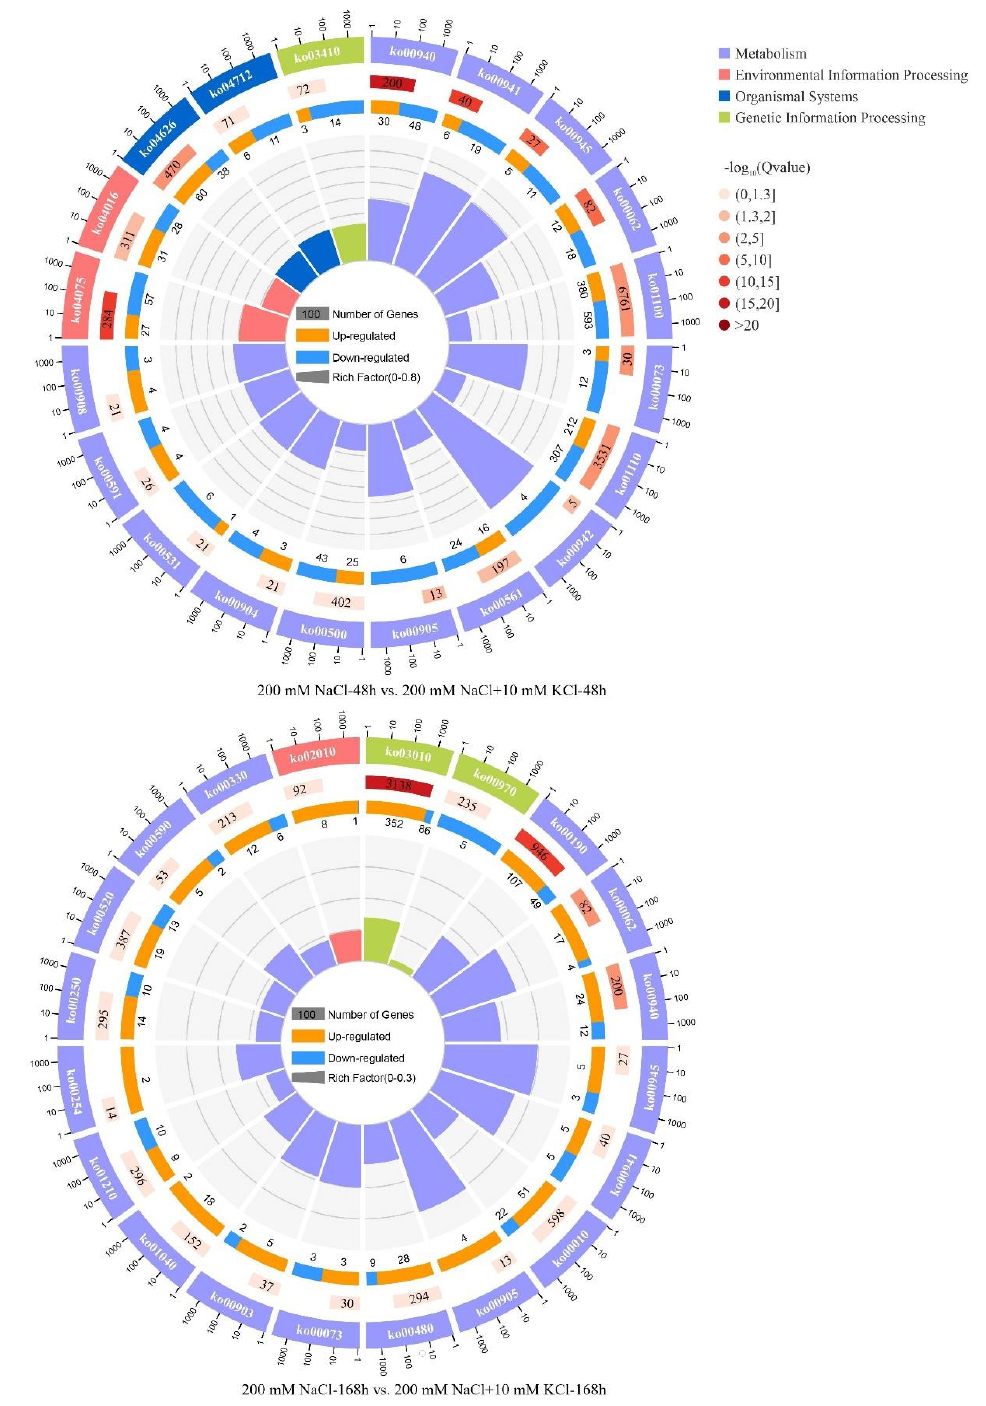
Figure 4. Top 20 KEGG pathways analysis in the transcriptome. First and outer circle: the top 20 KEGG pathways are enriched, outside the circle is the scale of the number of genes. Different colors represent different ontologies. Second circle: the number of the KEGG pathway in the background gene and the Q value. Moreover, the darker the color, the smaller the Q value. The longer the bars, the more genes it contains. The dark color represents the proportion of upregulated genes, and the light color represents the proportion of downregulated genes. The specific value is displayed below. Fourth and inner circle: the ratio of each KEGG pathway rich factor value (the number of differential genes in this KEGG pathway divided by all numbers); background grid lines, each grid represents